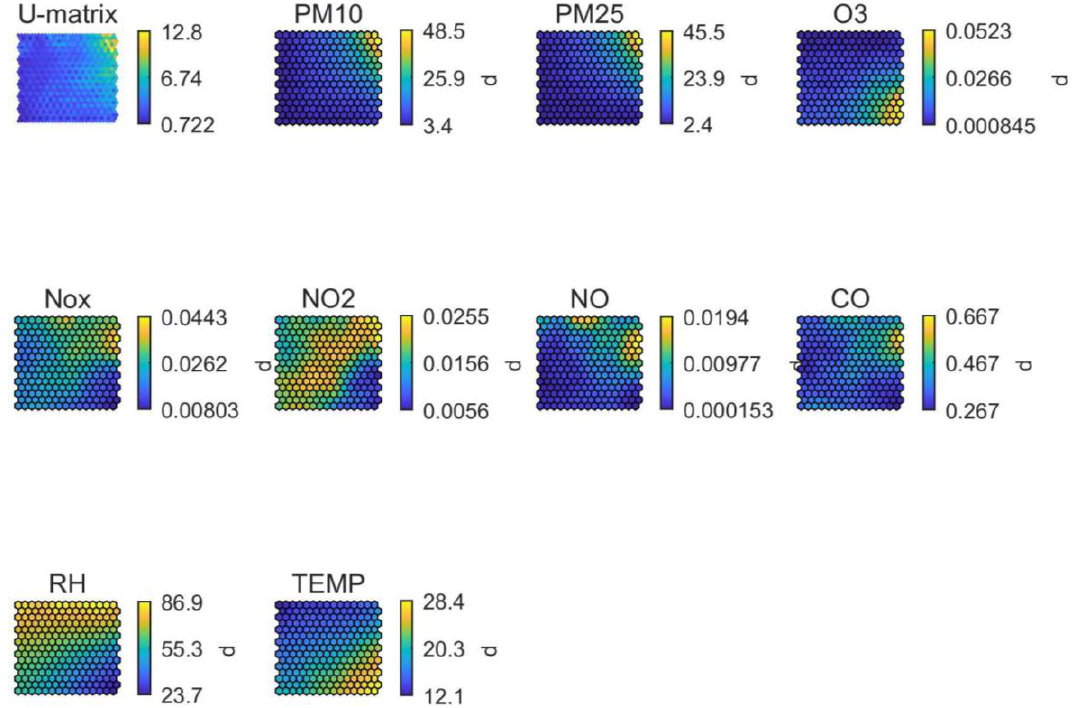
Figure 9. SOM of available data for stadium #6, in America. The colour scale is automatically adjusted among graphs and does not reflect the full range of values per parameter.